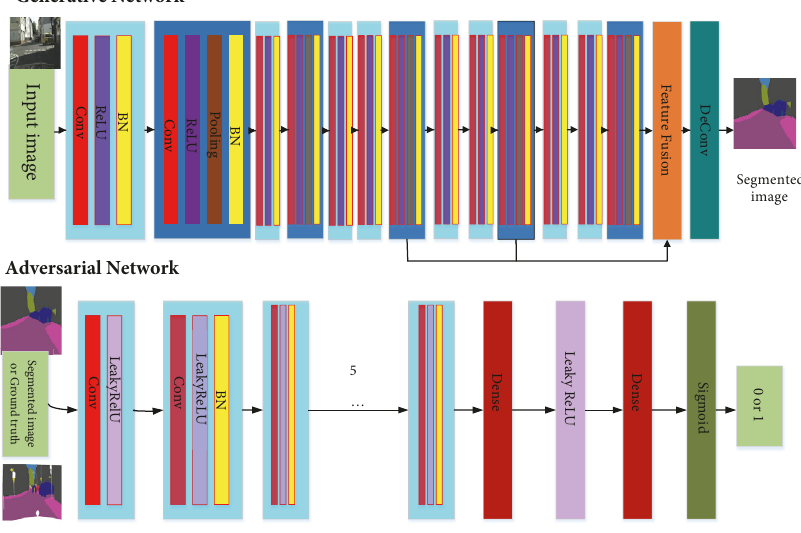
Figure 3: Architecture of generative and adversarial